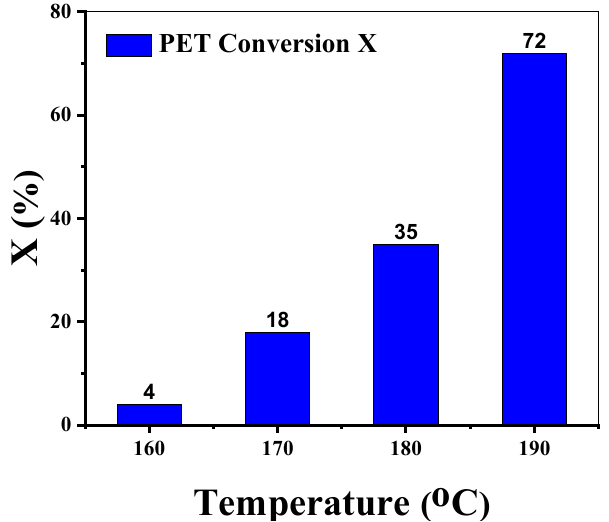
Figure 1. Temperature screening using MeONa as a glycolysis catalyst. Reaction conditions: T = 160–190 ◦ C, PET: Cat = 100 (mol/mol), EG: PET = 5 (mol/mol), time = 4 h, PS = 1